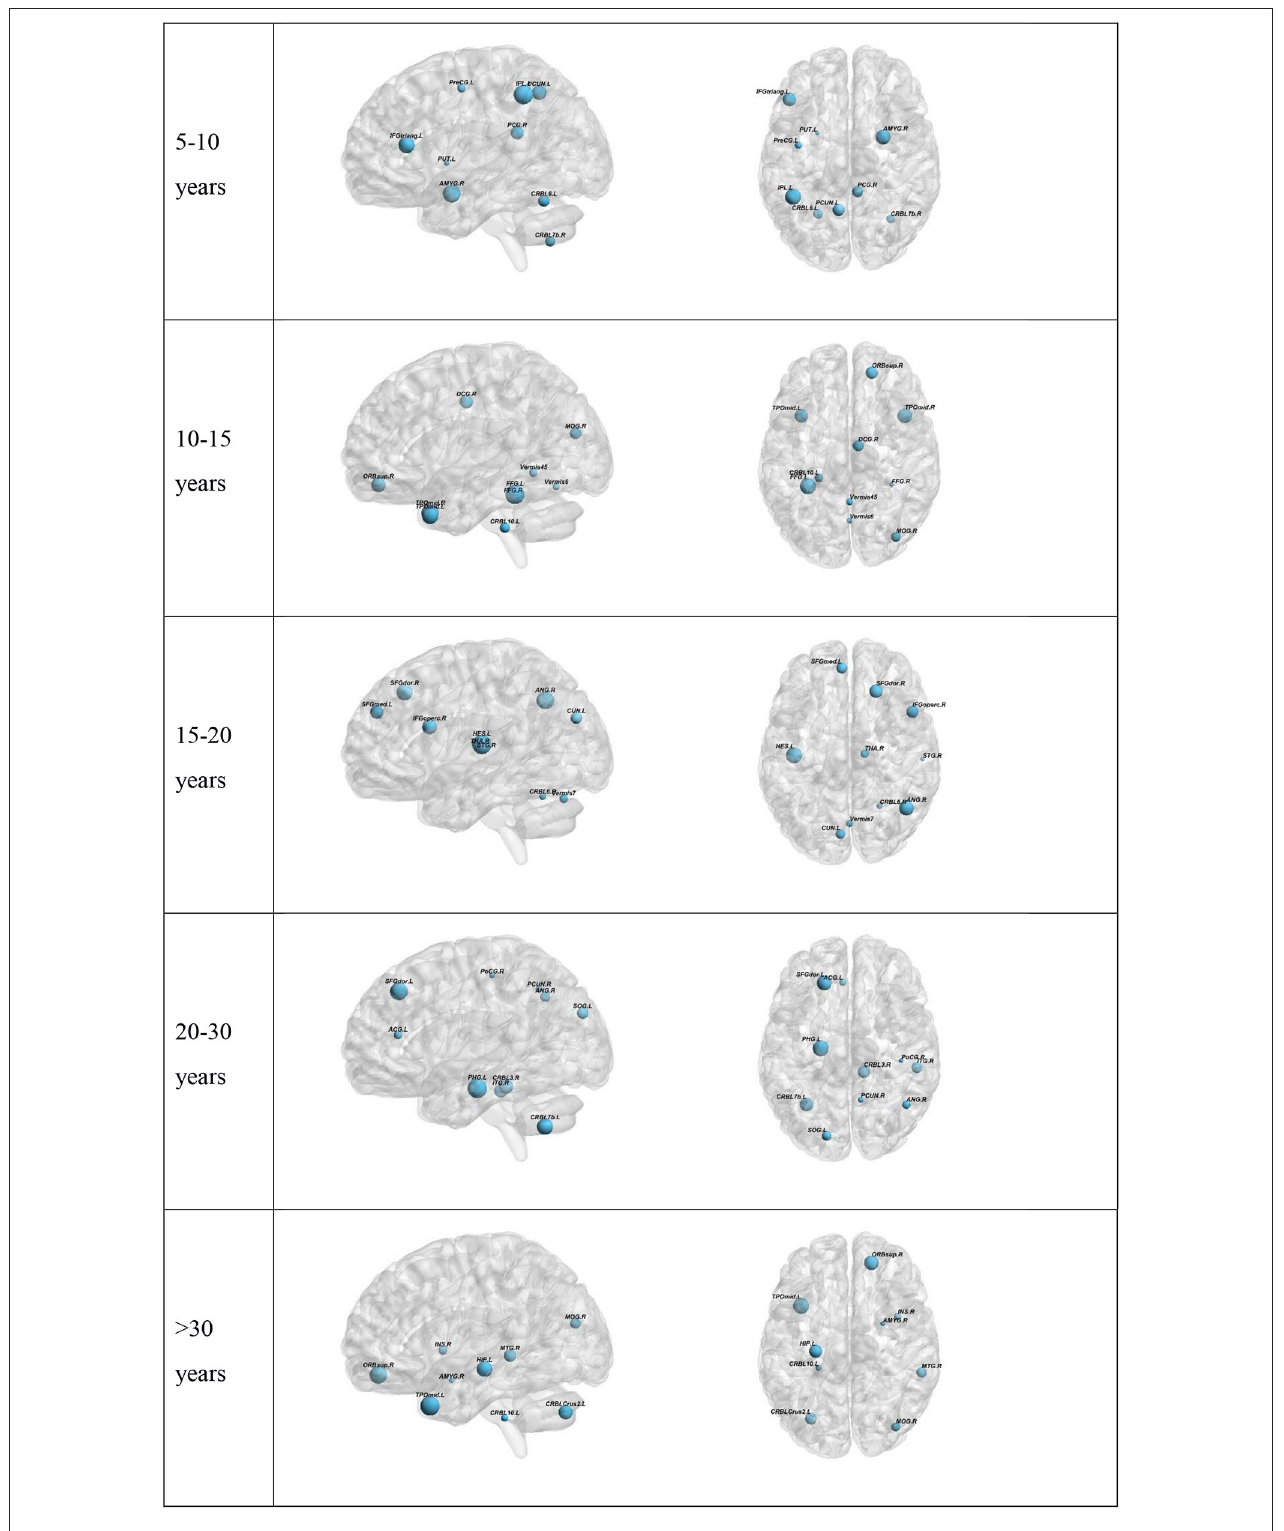
FIGURE 3 | Visualization of the top 10 selected features for each Age range. Two age-ranges show only 9 features. This is because in the 5–10 range PreCG.L was selected two times. In the > 30 group the last selected feature was the global Characteristic path length. The full region names along with the abbreviations can be found in Supplementary Table B